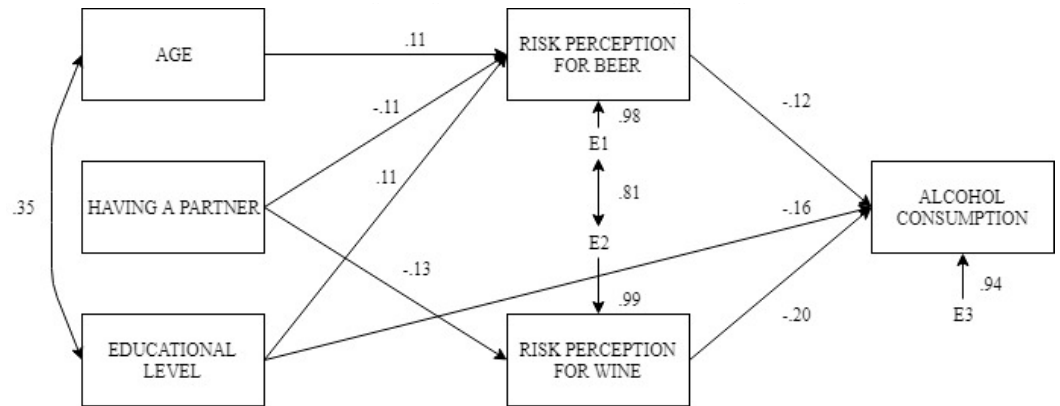
Figure 6. Structural equation model of risk perception and demographics as determinants of frequency of alcohol consumption during pregnancy.